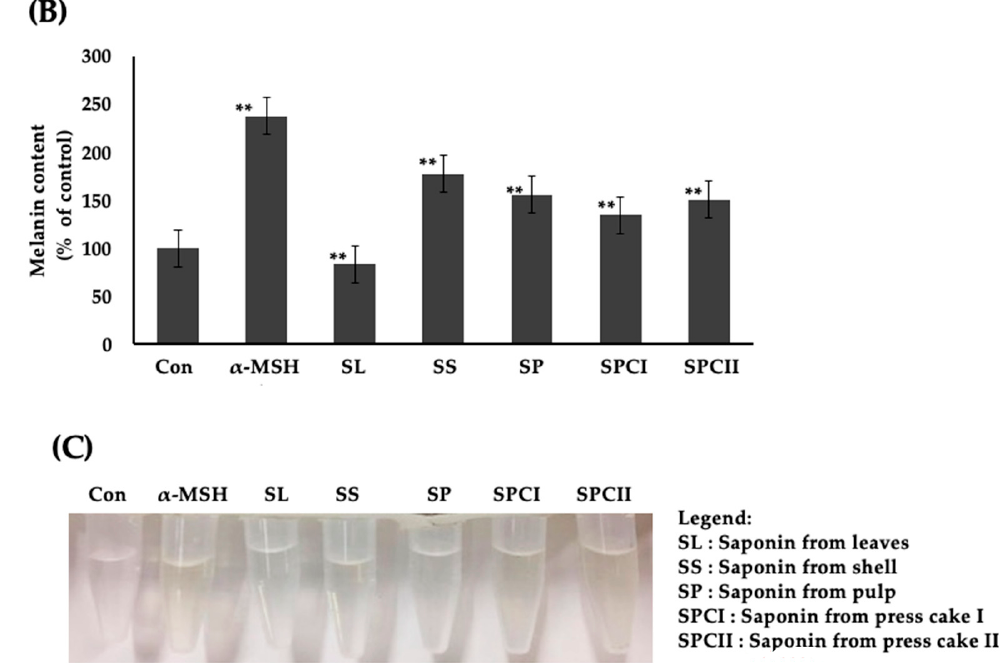
Figure 1. Effect of saponins-rich fraction of argan samples on proliferation and melanin content of B16 cells. ( A ) Cell proliferation of B16 cells determined using MTT assay. B16 cells were seeded at a density of 3 × 10 3 cells per well of 96-well plate. After overnight incubation, cells were treated for 48 h with 5 µ g/mL, 10 µ g/mL, and 20 µ g/mL of saponins-rich fraction of argan leaves (ALS), argan shell (SS), argan fruit pulp (SP), press cake from roasted argan (SPCI), and press cake from nonroasted argan (SPCII). ( B ) Melanin content was quantified using melanin assay and expressed as melanin content/cell (% of control). B16 cells were seeded at a density of 5 × 10 5 cells per 100 mm Petri dish. After overnight incubation, cells were incubated for 48 h with 5 µ g/mL of saponins-rich fraction of ALS, SS, SP, SPCI, and SPCII. ( C ) Melanin extracted from B16 cells, as described in ( B ), dissolved in 99.5% ethanol. * indicates significance at p < 0.05, ** at p <